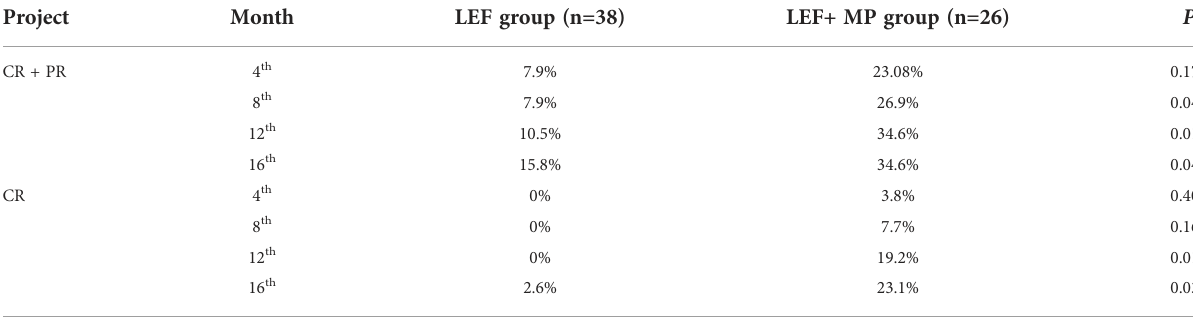
TABLE 2 P value and remission rates of the LEF + MP group compared with the LEF group.